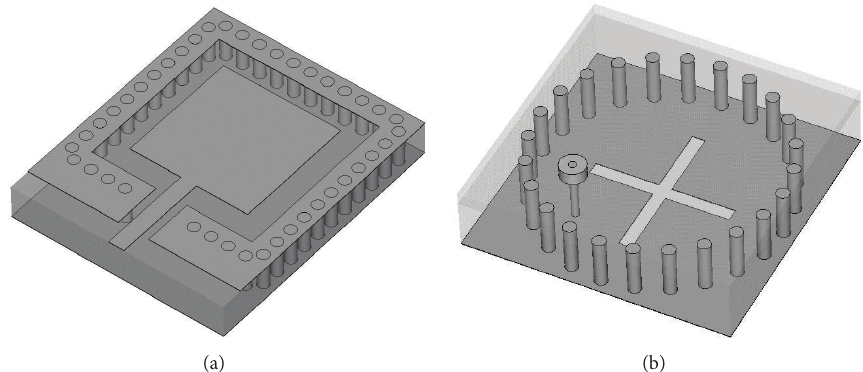
Figure 2: Low profile SIW cavity backed antennas: (a) patch antenna; (b) slot